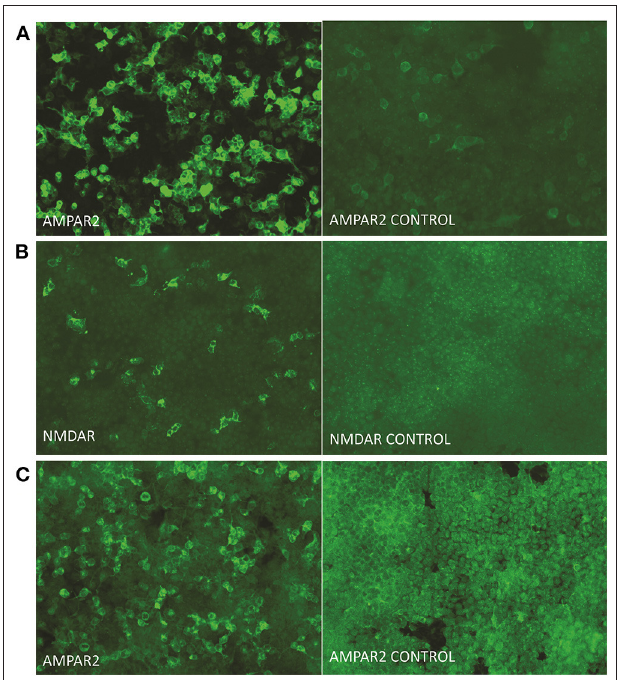
FIGURE 3 | Brain MRI showing increased scattered fluid-attenuated inversion recovery hyperintensity in the subcortical white matter and medial temporal lobe at 17 days (B) and 45 days (C) after onset compared with 6 days (A) after